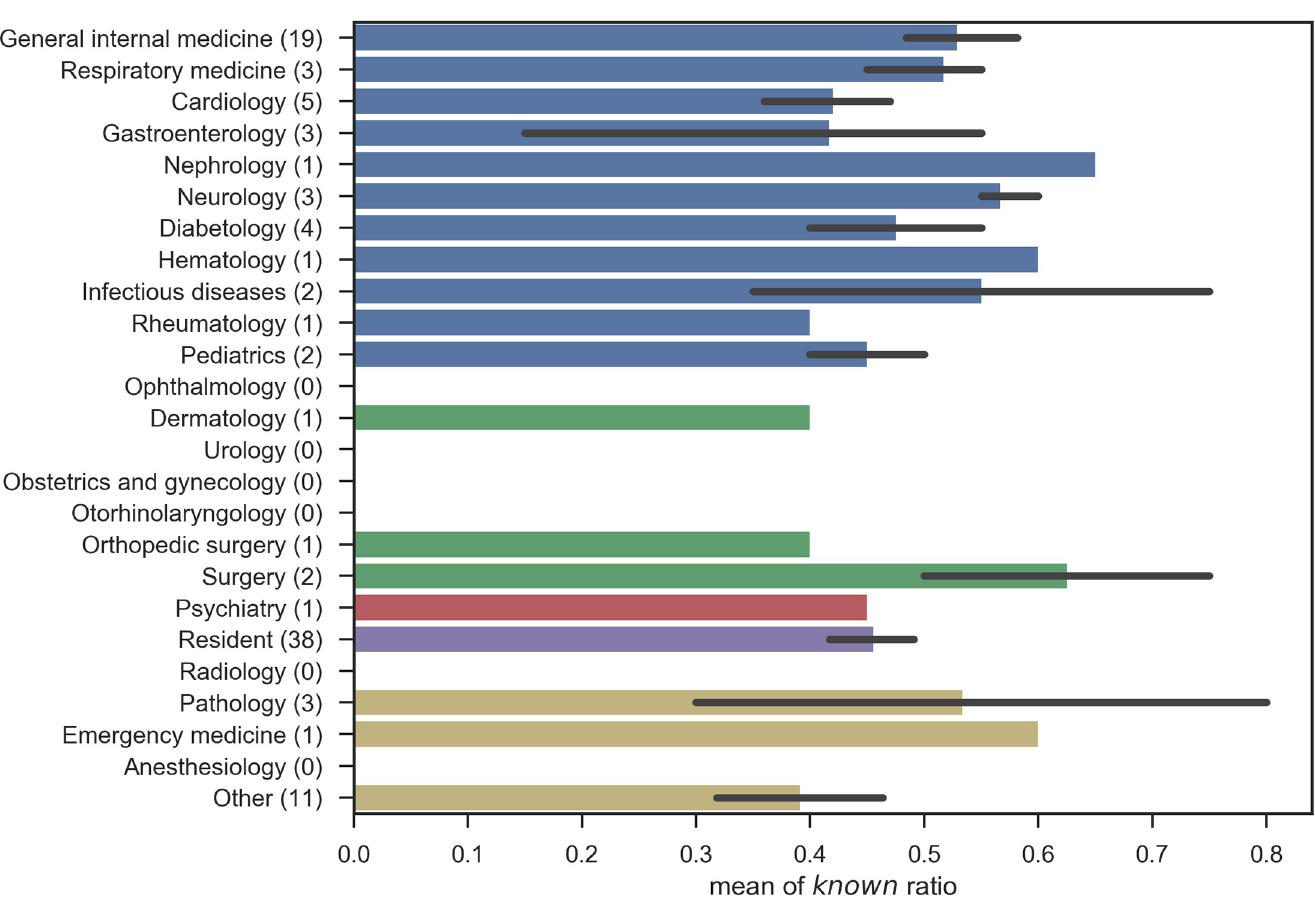
Fig 5. Known ratio, grouped by specialty: The error bars shows the standard errors. The bars without error bar contain only one data.